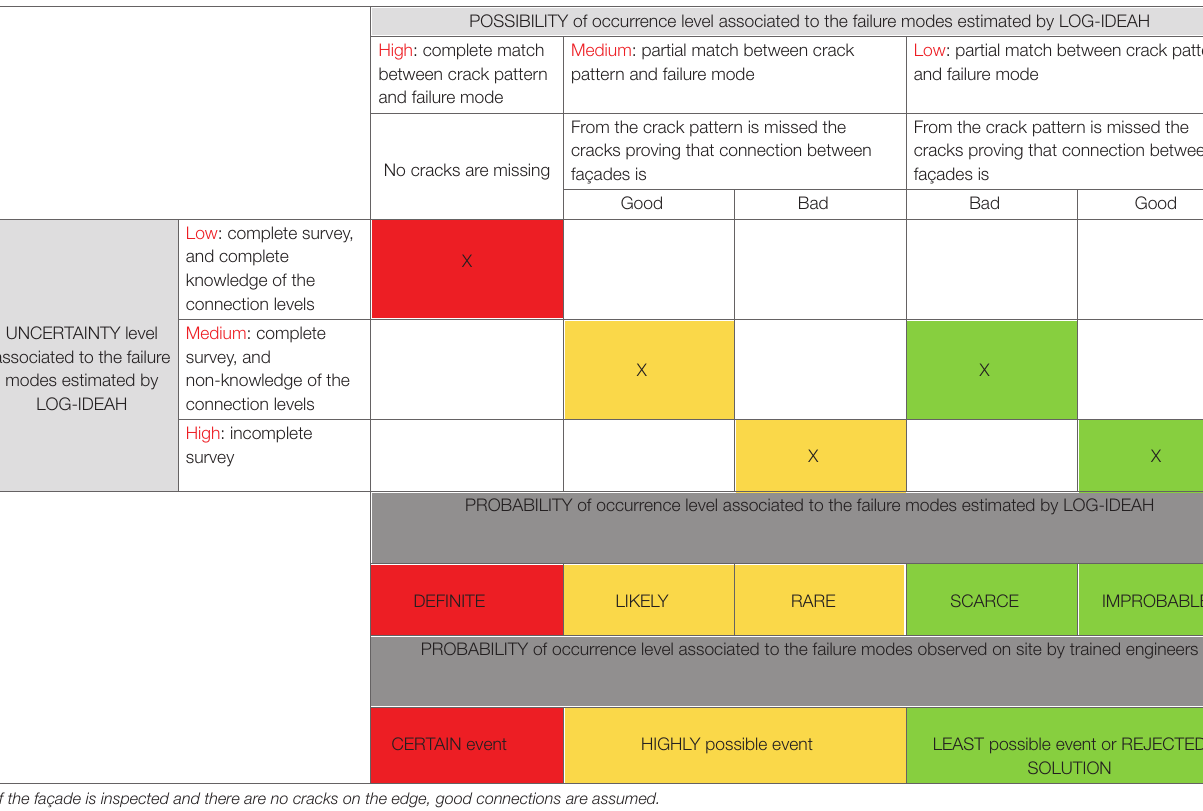
TABLE 2 | Conversion table, correlating failure mode occurrence estimated by LOG-IDEAH with available information related to cracks and structural conditions and failure mode occurrence observed on site by trained